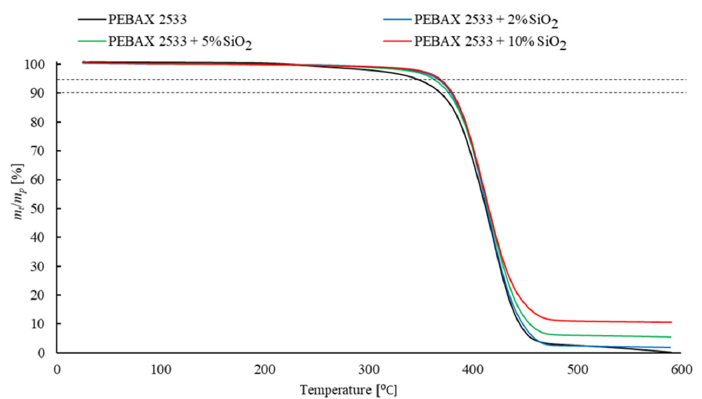
Figure 14. TGA analysis of membranes containing SiO 2 in different concentrations.